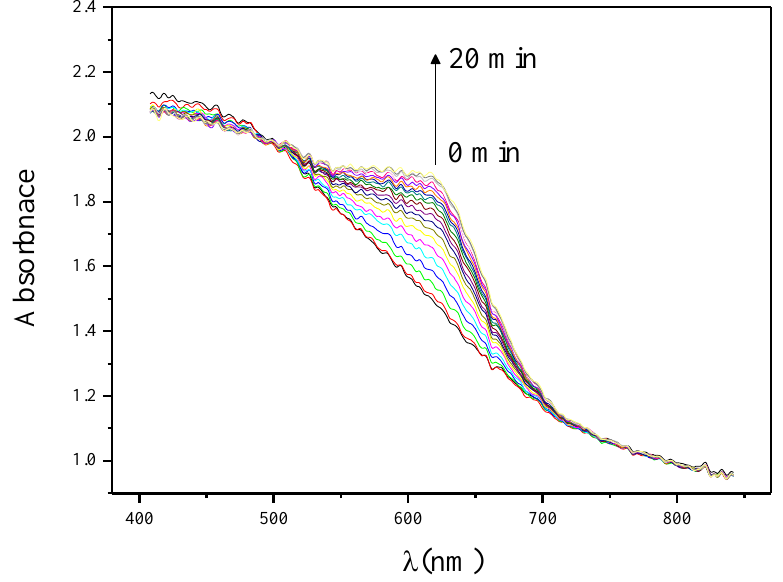
Figure 5. UV-Vis Spectrograms of Al-MCM-41(50)/BG as time proceeded for adsorbing NH . The ammonia gas concentration was 5 3